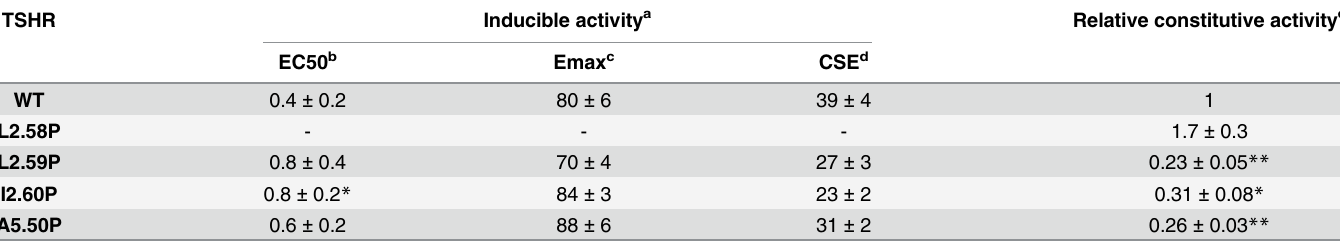
Table 1. Functional characterisation of cAMP accumulation by the TSHR